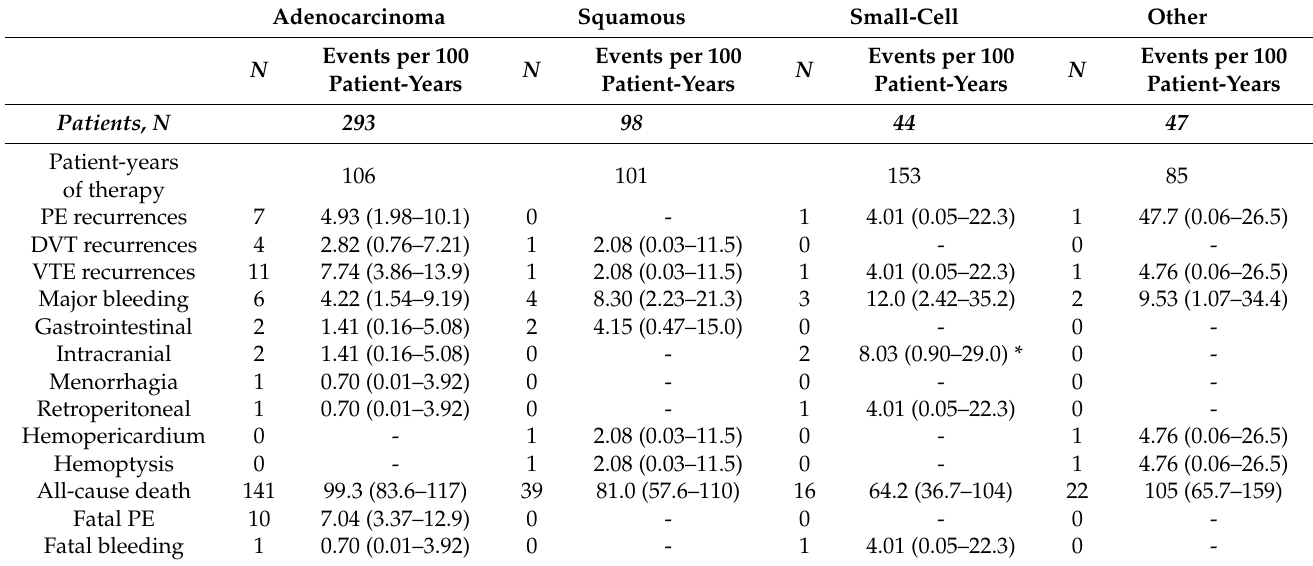
Table 3. Clinical outcomes during the course of anticoagulant therapy, according to the histology. Adenocarcinoma